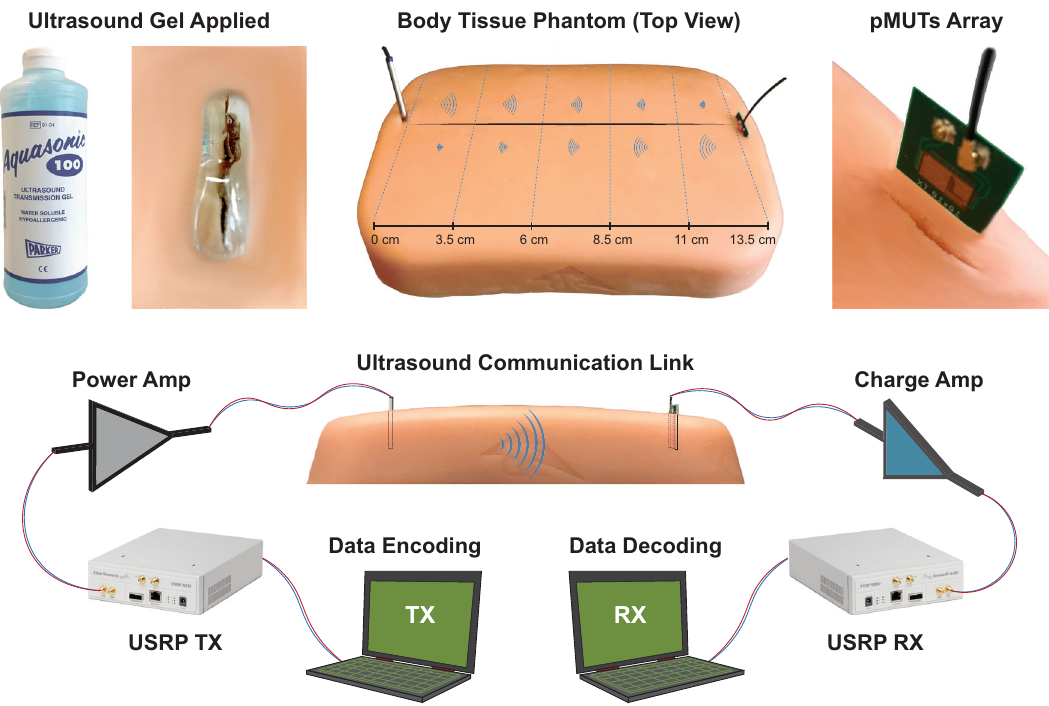
Fig. 3 Intrabody setup. LN pMUT arrays, wire-bonded to Printed Circuit Boards (PCBs) are implanted in a tissue phantom mimicking the human tissue properties. When implanting, the incised holes are fi lled with ultrasound gel to avoid air gaps that could reduce the intensity of the ultrasonic signal. Furthermore, the communication link is implemented with a transmitting and a receiving Universal Software Radio Peripheral (USRP). The signal of the TX USRP is ampli fi ed by an off-the-shelf power ampli fi er while the RX USRP is conditioned by an in-house custom-made charge ampli fi er designed to match the impedance of the LN pMUT array. In this setup, both TX and RX are LN pMUT arrays.